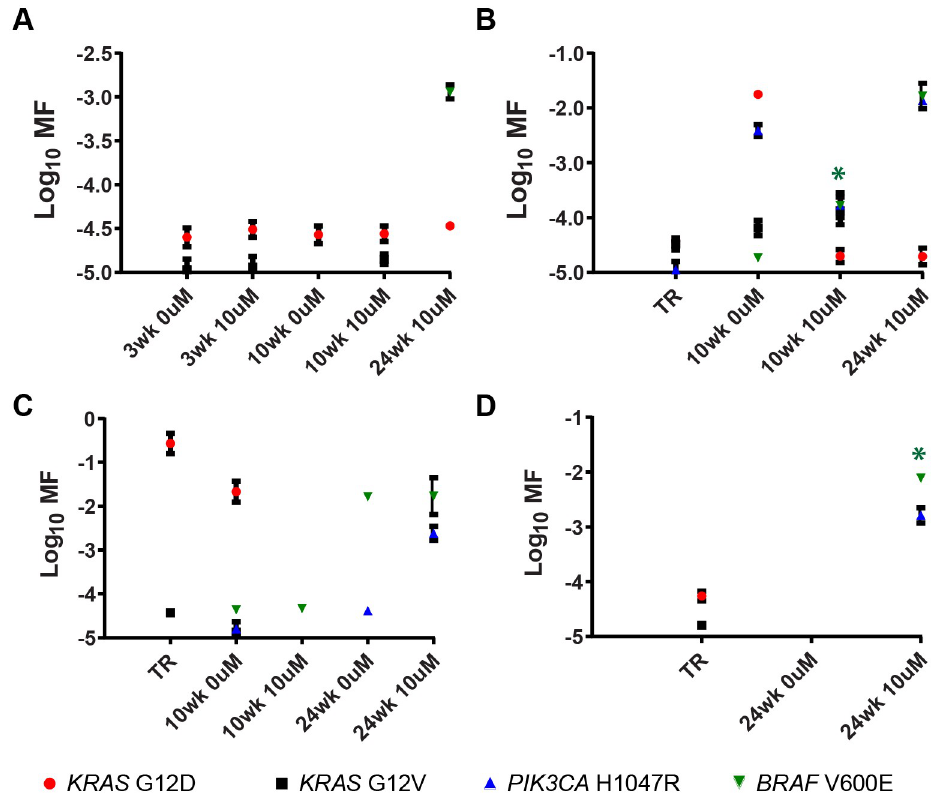
Fig 9. Quantification of mutant subpopulations in DNA harvested from long-term spheroid cultures. Mutant quantification in cultures derived from: (A) Tumor 11, (B) Tumor 12, (C) Tumor 13, (D) and Tumor 14 are shown. Asterisks denote MF measurements significantly greater than that of both TR and its corresponding 0 μ M erlotinib culture (one-sided Mann Whitney test, P = 0.0500).